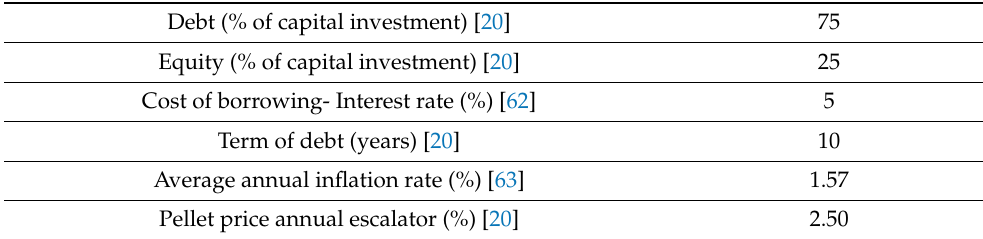
Table A3. The assumptions used to estimate the production cost of